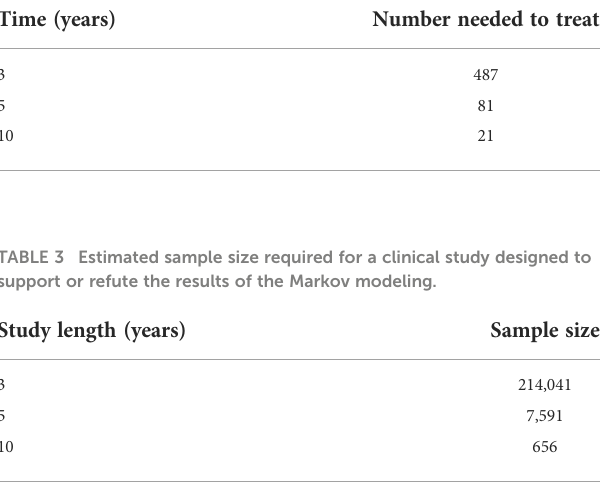
TABLE 2 Number needed to treat to observe one additional serious non-AIDS event (cardiovascular, hepatic or renal event, or malignancy) or all-cause death, with the two-drug ART regimen versus the three- drug regimen, by time on ART.